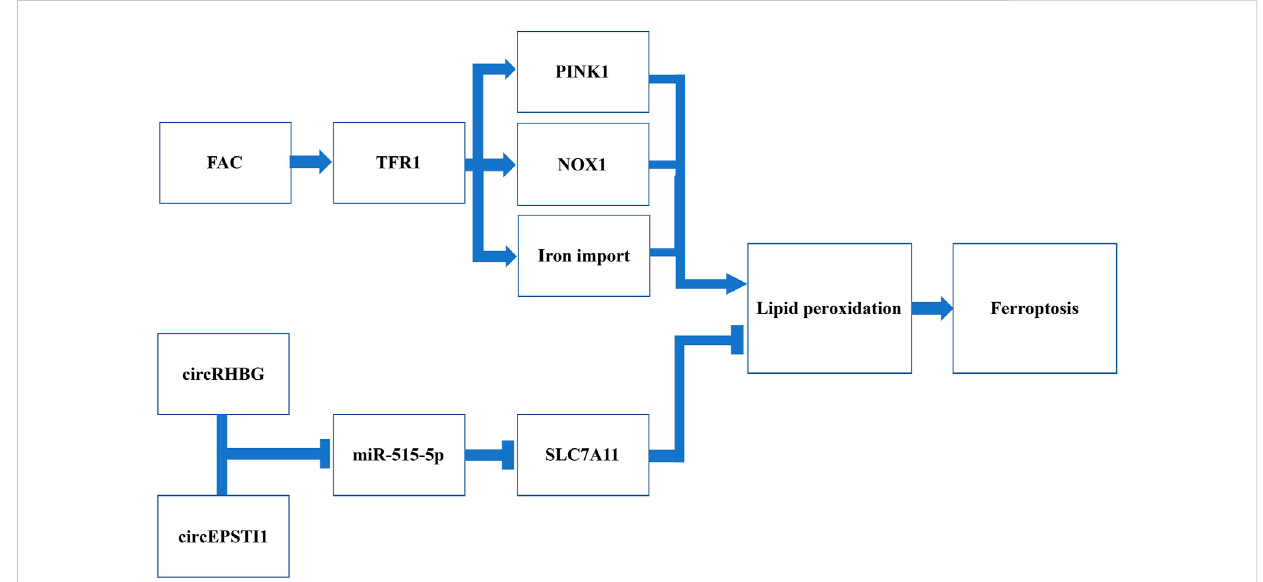
FIGURE 4 SchematicrepresentationofpotentialtargetstriggeringferroptosisforPCOSmanagement.InductionofFACissuggestedtopromoteironimportby increasing the expression of TFR1 in DHEA-injected mice. In addition, the induction of FAC has been demonstrated to further activate the NOX1 and PINK1, two factors inducing ROS and ultimately lipid hydroperoxides. CircRHBG and circEPSTI1 are two circRNA that can inhibit miR-515-5p and further de-suppresstheexpressionofSLC7A11,oneofthesystemXc − subunits.Therefore,silencingthesetwocircRNAcanreducetheexpressionofsystem Xc − , thus leading to antioxidants depletion. Collectively, both induction of FAC and silencing circRHBG as well as circEPSTI1 have been revealed to promote lipid peroxidation and trigger